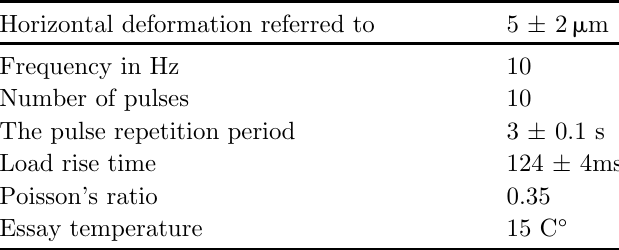
Fig. 2. Some test specimens were taken from the site. Table 1. summarizes the conditions of the essays.